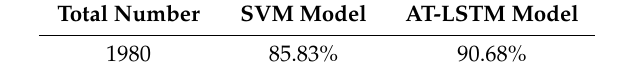
Table 14. Model recognition accuracy for 0.6 s in advance.